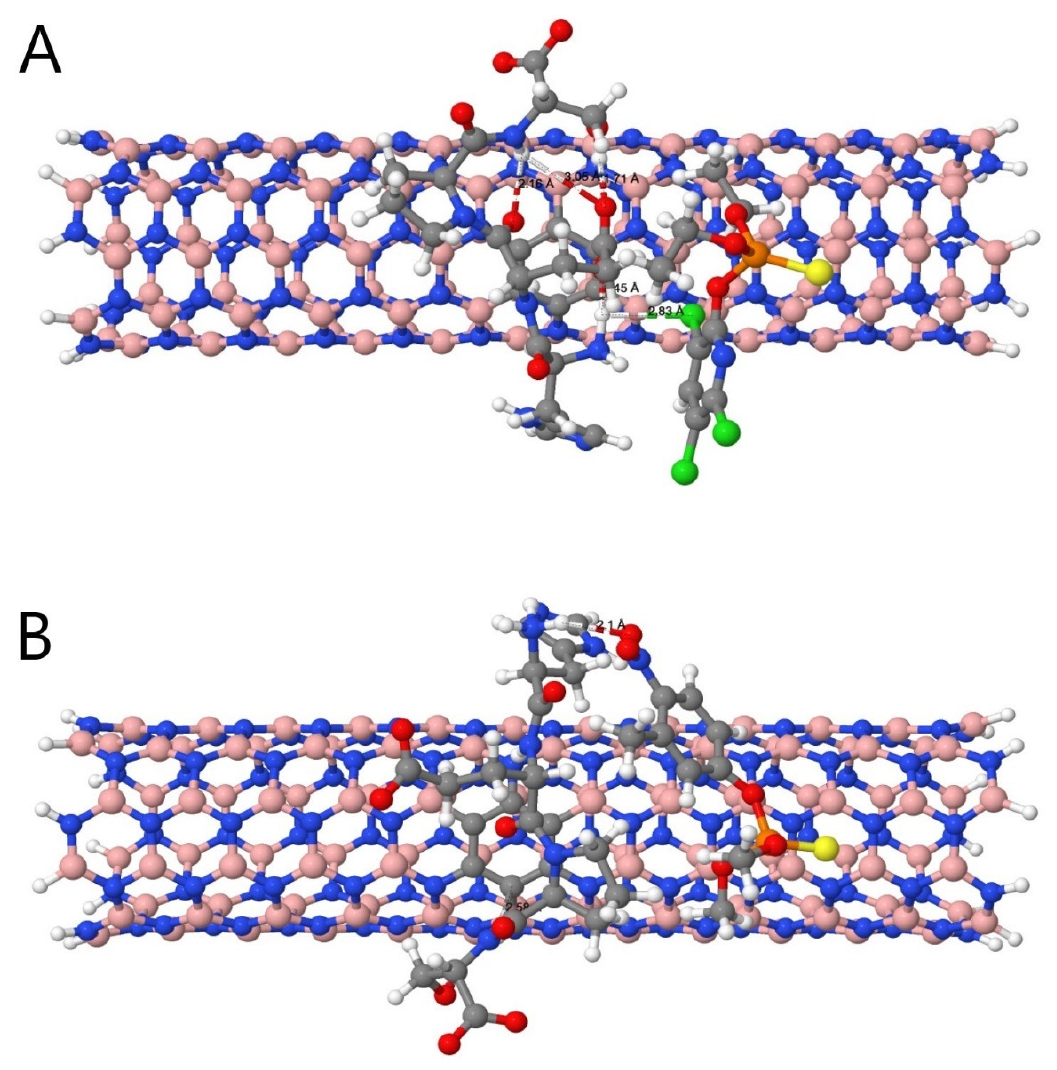
Figure 2. Equilibrium structures of pesticides (( A ) chlorpyrifos (chl) and ( B ) fenitrothion (fen)) ad- sorbed on carbon-doped armchair (5,5) boron nitride nanotube (BN55-CC1) decorated with tetrapeptide (4pep). Table 1. Reaction enthalpy ( ∆ H f in kcal/mol) of chlorpyrifos (chl) and fenitrothion (fen) adsorbed on carbon-doped armchair (5,5) boron nitride nanotube (BN55-CC1) without and decorated with tetrapeptide (4pep).